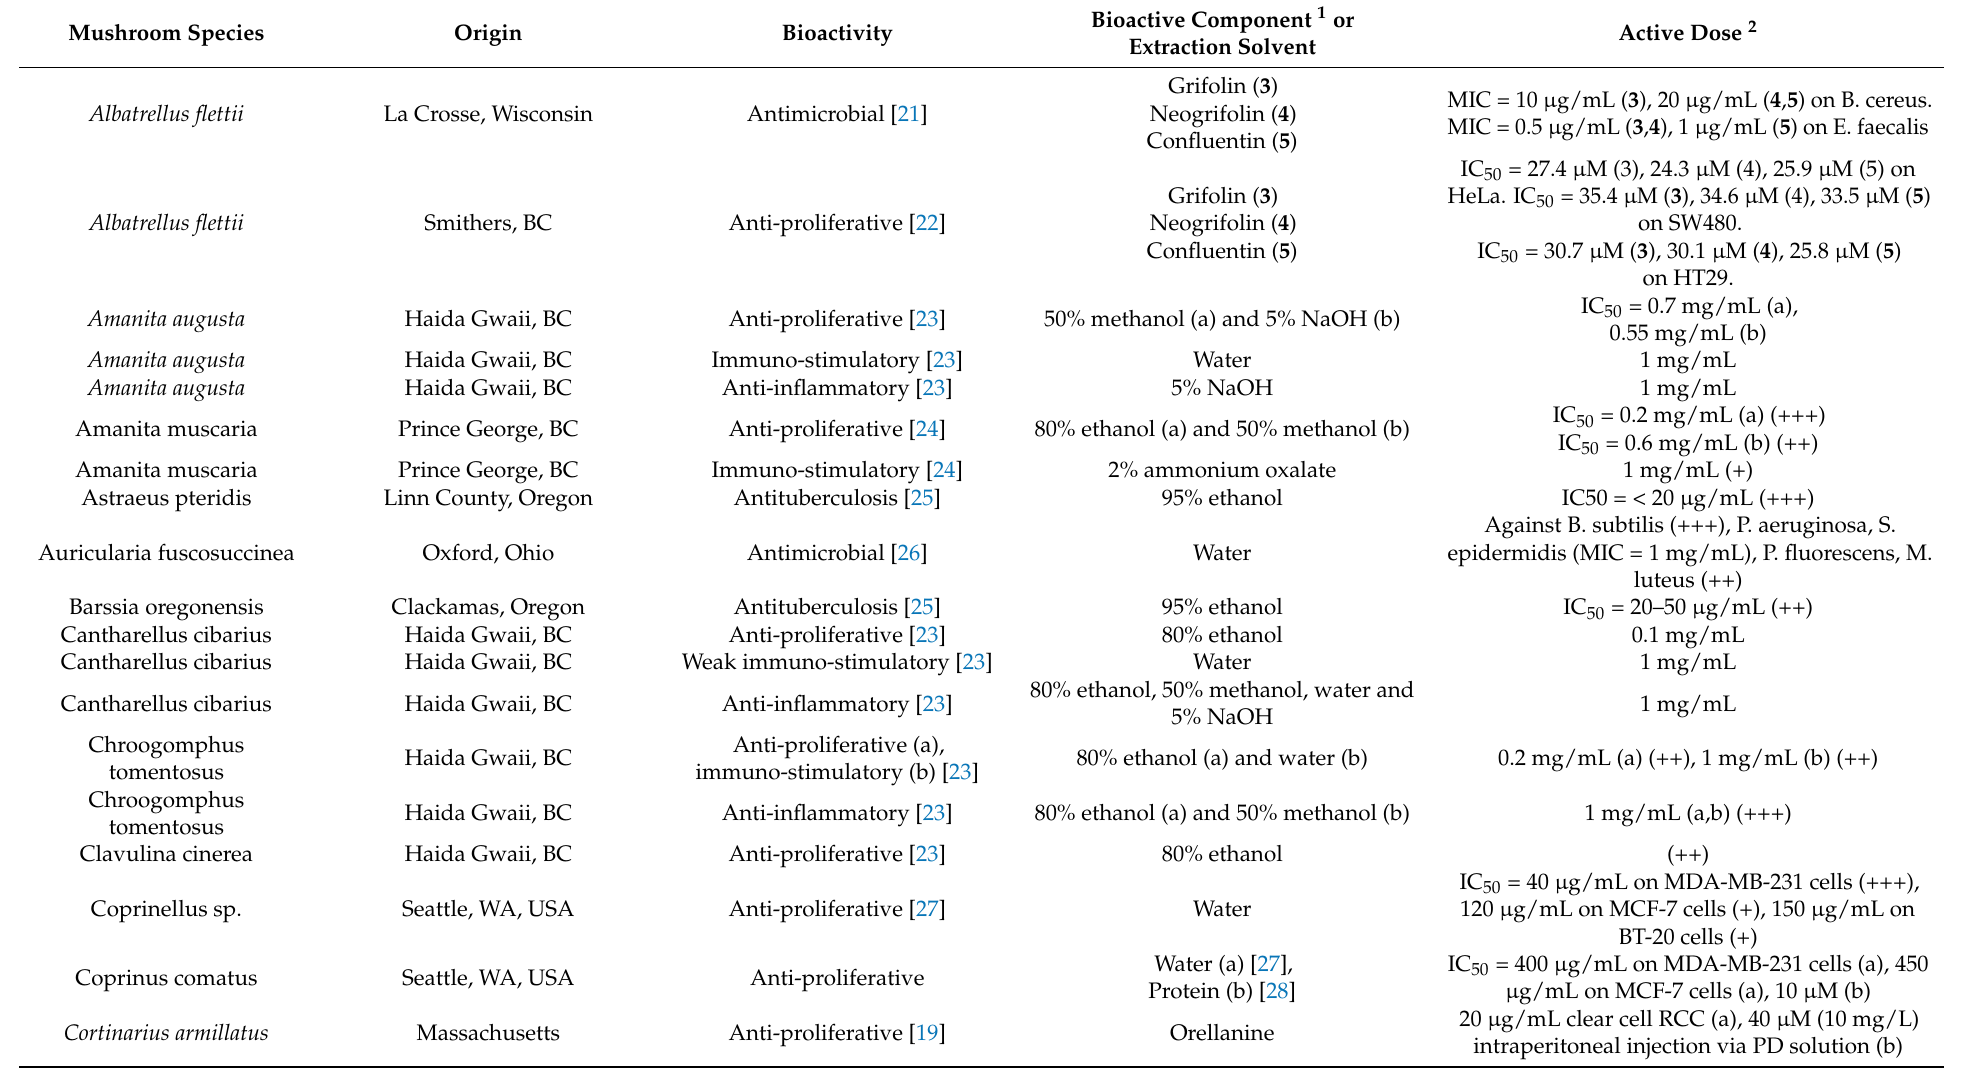
Table 1. Mushrooms Native to North America Studied for